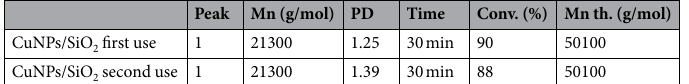
Table 1. GPC analysis – BA polymerization with catalyst recycling.